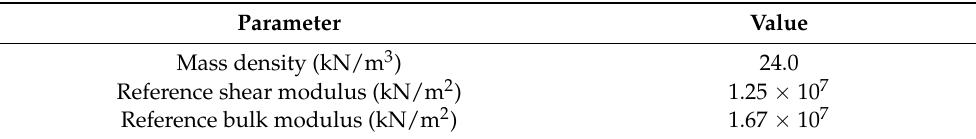
Table 2. Characteristics of the